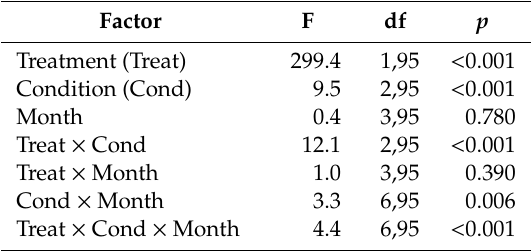
Table 6. Overall ANOVA (Proc Mixed, Statistical Analysis System, Version 9.4), live larvae after 5 days, for main e ff ects treatment (untreated controls versus the methoprene-deltamethrin-piperonyl butoxide formulation) condition (larvae exposed on the clean treated arenas with new food, the food-treated arenas with replaced food, and the untreated arenas with transferred treated food, and month post-treatment (0, 1, 2, or